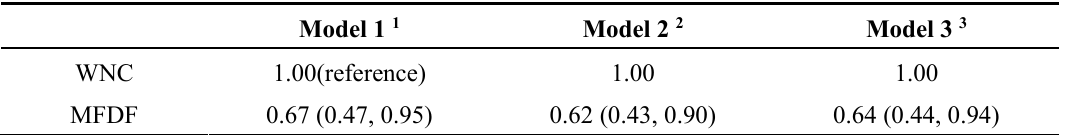
Table 4. Odds ratio with 95% confidence interval for cognitive impairment according to dietary